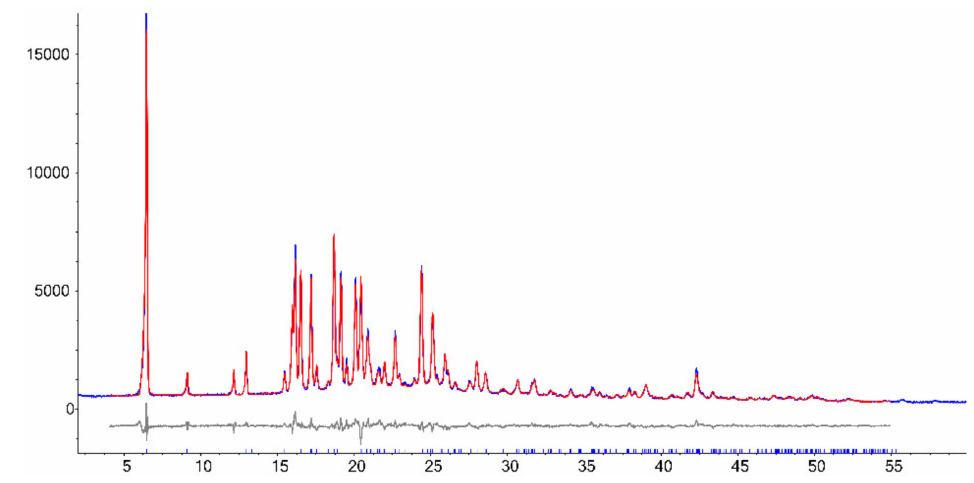
Figure 5. Rietveld refinement fit of the experimental pattern (red) and the calculated one (blue). In grey are the corresponding